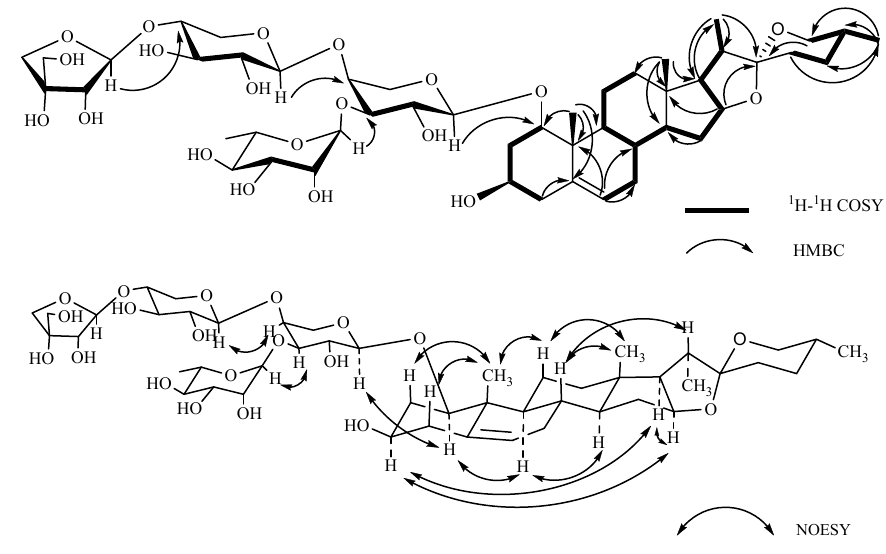
Figure 2. Key 1 H- 1 H COSY, HMBC, and NOESY correlations of compound 1 . Compound 2 , named Pamaiosides B, a white amorphous solid, was positive to Liebermann Burchard and Molisch chemical reactions. The pseudomolecular ion peak was measured in the HR-ESI-MS spectrum at m/z 1043.4677 [M + Na] + (calculated for C 48 H 76 O 23 Na, 1043.4675), corresponding to the molecular formula C 48 H 76 O 23 . Compared to 1 , one angular methyl at δ C 15.07 (C-21) and two methylenes at δ C 32.59 (C-23) and 30.04 (C-24) were absent, and the chemical shifts were all markedly up-field at δ C 62.95 (C-21, ∆ δ C + 47.88 ppm), δ C 71.20 (C-23, ∆ δ C + 38.61 ppm), and δ C 74.01 (C-24, ∆ δ C + 43.97 ppm), respectively, which indicates that a hydroxyl group substituted at the primary carbon atom (Tables 1–4). In the HMBC spectra, the cross-peaks between δ H 2.78 (H-20) and δ C 62.95 (C-21) and between δ Ha 3.55, δ Hb 3.69 (H-21) and δ C 46.04 (C-20)/ δ C 112.72 (C-22) au- thenticated the hydroxyl substituted at C-21, and it was further confirmed by the correla- tions for δ Ha 3.55, δ Hb 3.69 (H-21) to δ H 2.78 (H-20) in the 1 H- 1 H COSY spectrum (Figure 3). Meanwhile, the correlations for δ H 1.91 (H-25) to δ H 3.76 (H-24) and δ H 3.76 (H-24) to δ H 3.52 (H-23) in the 1 H- 1 H COSY spectrum and the signal of δ H 0.90 (H-27) to δ C 74.01 (C-24) derived from the HMBC spectrum illustrated that the hydroxyl displaced at C-23 and C- 24. In the NOESY spectra, the configurations of C-1, C-3, C-23, and C-24 were successively evidenced as β , β , α , and β orientations derived from correlations for H-1 ( δ H 3.40) to H-9 ( δ H 1.25), H-3 ( δ H 3.38) to H-9 ( δ H 1.25), H-20 ( δ H 2.78) to H-23 ( δ H 3.52), and H-24 ( δ H 3.76) to H-27 ( δ H 0.90), respectively. Using the same method as for 1 , C-20, C-22, and C-25 were determined as R configuration. By summarizing the data and comparing it to the literature [22], the aglycone of compound 2 was established as (20 R ,22 R ,25 R )-spirost-5-en- 1 β ,3 β ,21,23 α ,24 β -pentol. Acid hydrolysis, derivatization, and GC analysis revealed that compound 2 pos- sessed the same monosaccharide residues as 1 , but different linkages emerged between the sugars. In the HMBC spectra, the sugar sequencing linkages were testified by the cor- relations between Api H-1 ( δ H 5.21) and Rha C-3 ( δ C 80.45), Rha H-1 ( δ H 5.33) and Xyl C-2 ( δ C 74.89), Xyl H-1 ( δ H 4.43) and Ara C-3 ( δ C 85.25), and Ara H-1 ( δ H 4.34) and C-1 ( δ C 84.80). Thus, compound 2 was elucidated as (20 R ,22 R ,25 R )-spirost-5-en-1 β ,3 β ,21,23 α ,24 β -pentol- 1- O - β - D -apiofuranosyl-(1 → 3)- α -L-rhamnopyranosyl-(1 → 2) - β - D -xylopyranosyl-(1 → 3)- a - L-arabinopyranoside.